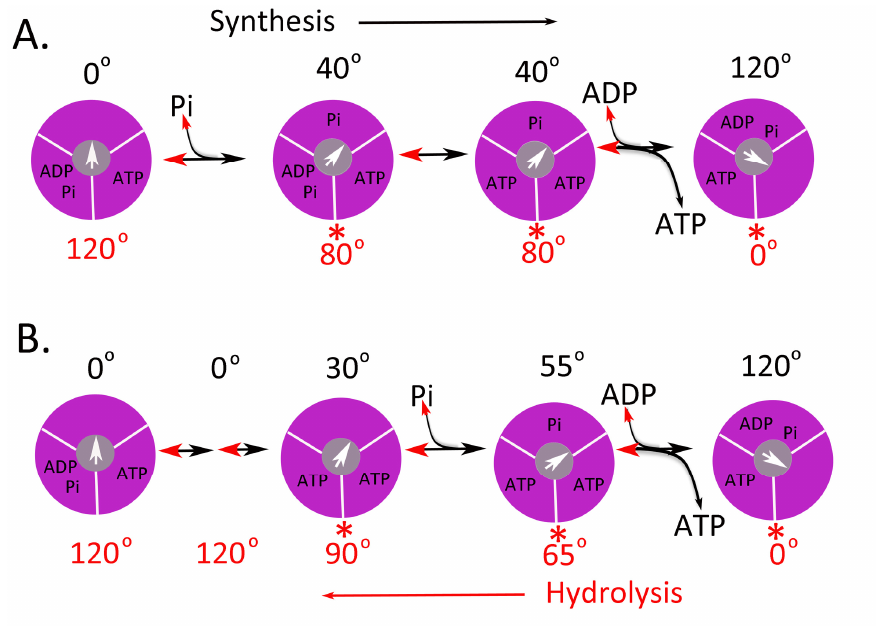
FIGURE 2: Possible scheme for site occupancy during ATP